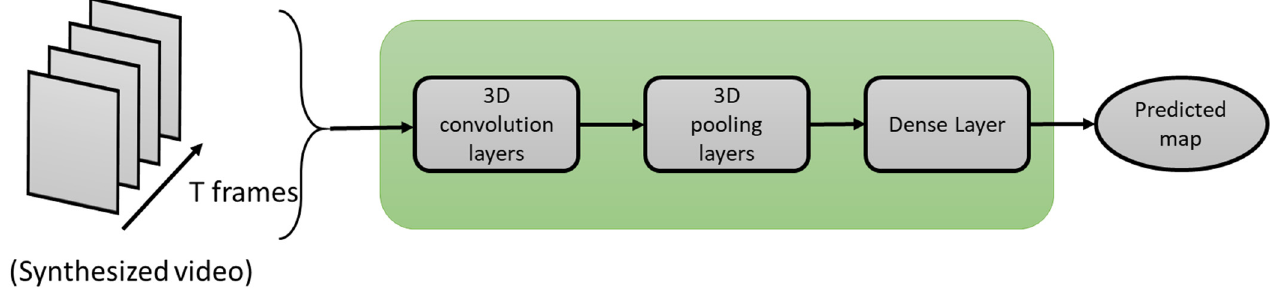
Figure 11. Architecture of iPPG-3D-CNN.